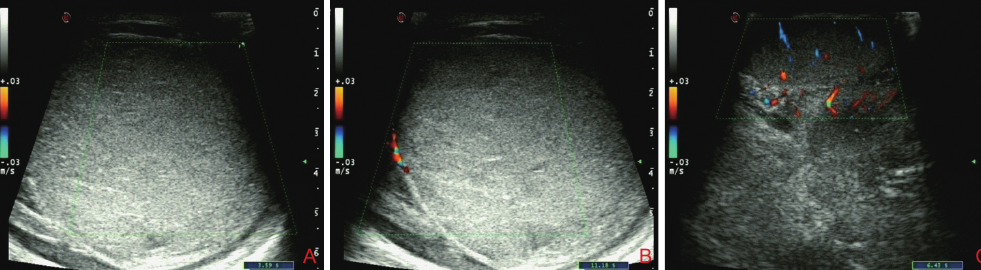
A Figure 5 A twenty-five-year-old man had right-sided testicular tumor which was removed by surgery (orchiectomy). Histopathologic results showed the tumor was a seminoma. (A) and (B) CDU imaging in the longitudinal plane shows ABF in the right testis. The image also shows the enlarged right testis; (C) CDU imaging in the longitudinal plane shows normal vascularization of the left testis in similar Doppler parameters as shown in images A and B. 226